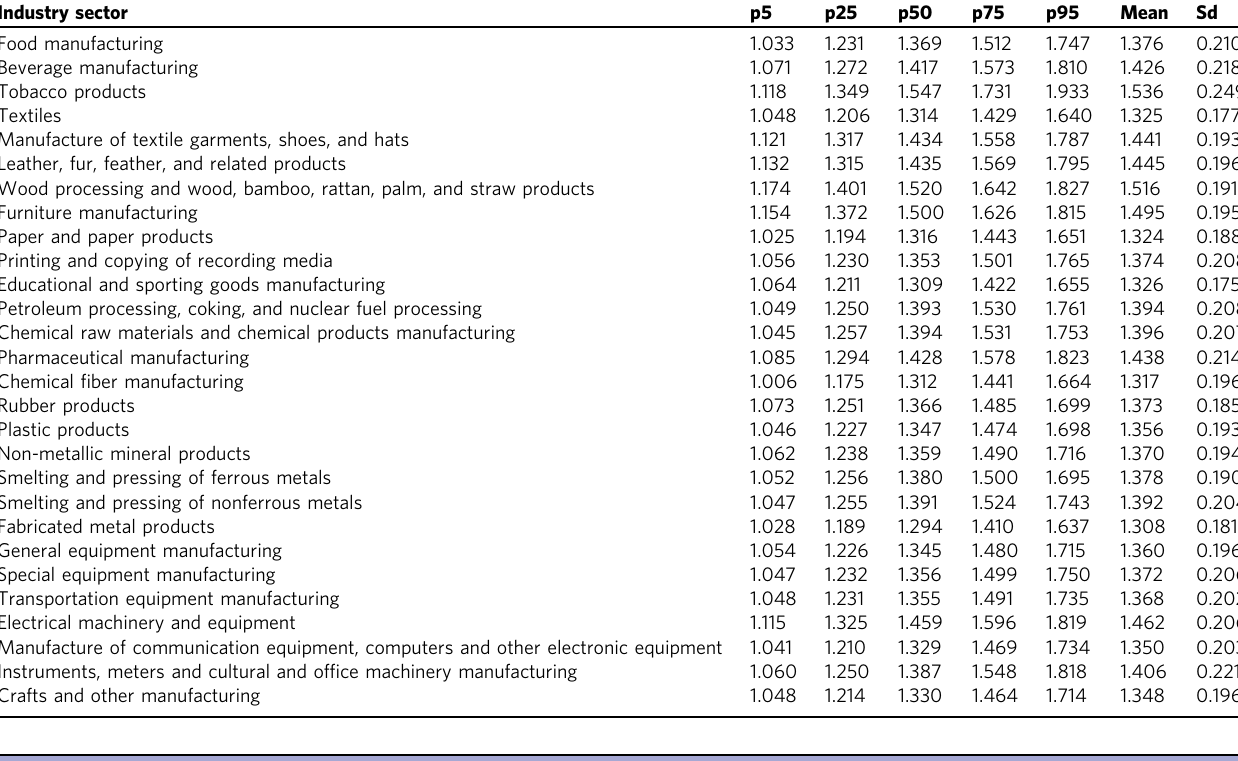
Table 1 Average markups and quantiles for each industry.